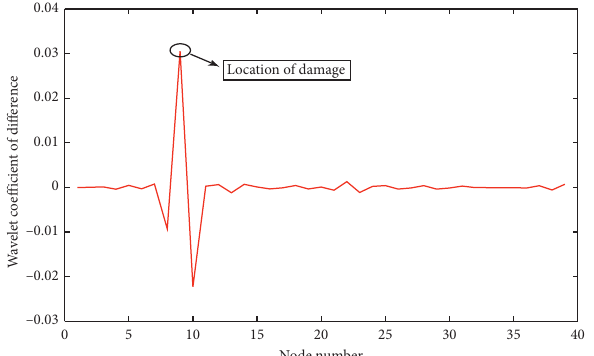
Figure 4: Wavelet coefficient difference graph for 6% damage in section 9.